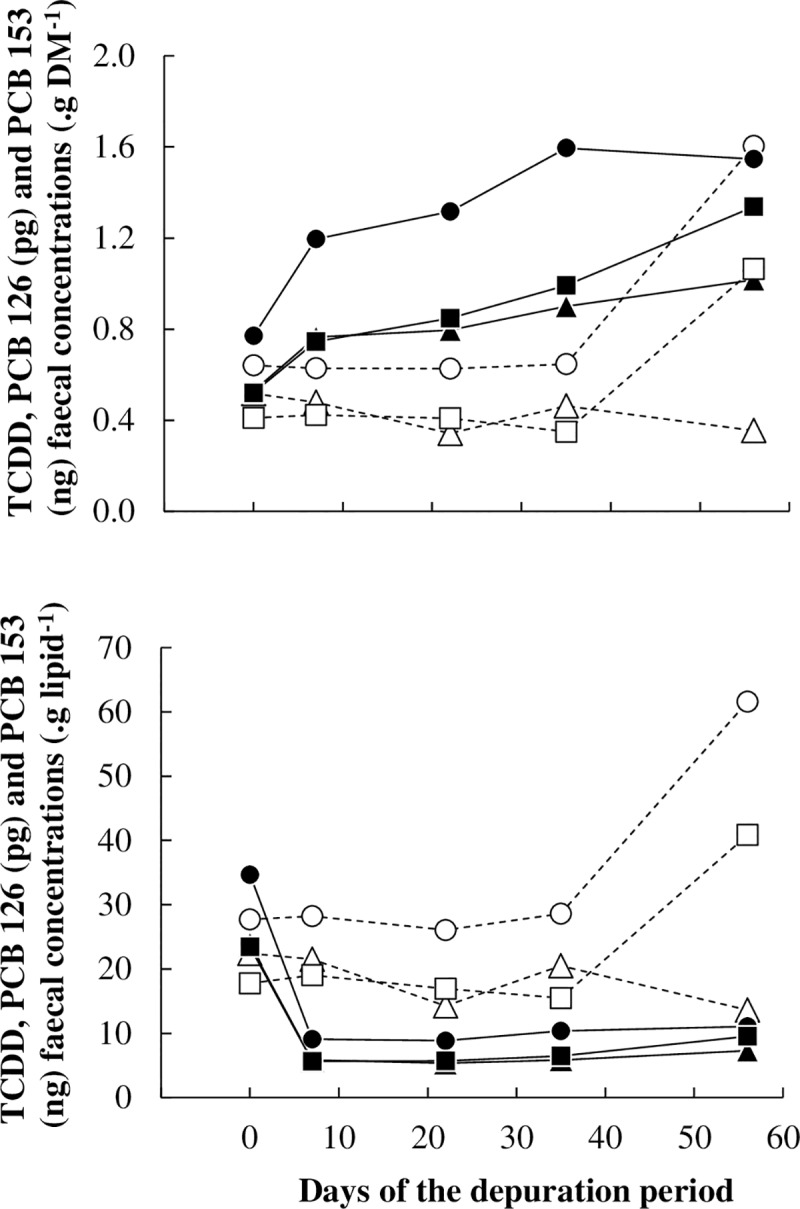
Time pattern kinetics of pollutants faecal concentrations based on dry matter (DM) or on lipids; with TCDD (▲, Δ), PCB 126 (●, ○) and PCB 153 (■, □) in ewes receiving a control well-fed and non-supplemented treatment (CTL: Δ, ○, □) or an underfed and mineral oil supplemented treatment (UFMO: ▲, ●, ■).Each point represents individual results obtained from pools of faeces by treatment and by date.